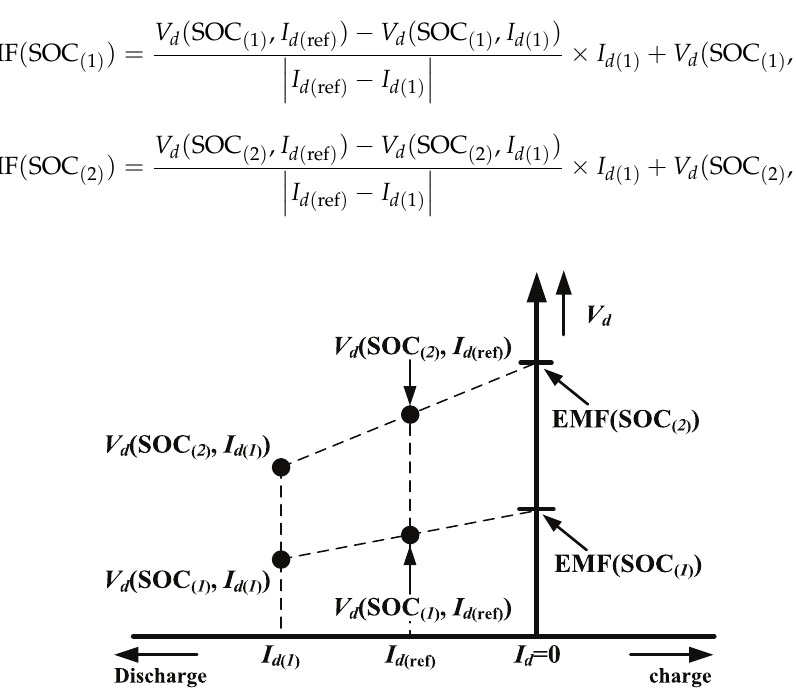
Figure 4. Demonstration of linear extrapolation for EMF extraction using I d ( 1 ) and I d ( ref )